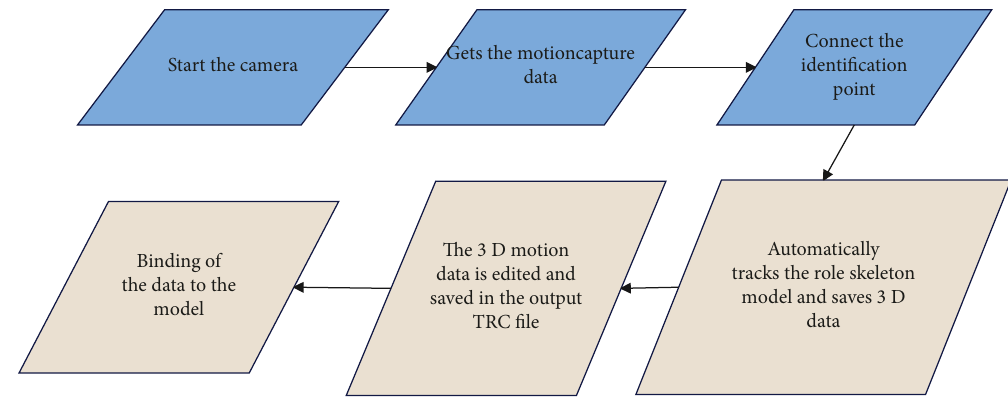
Figure 6: The dance movement skill feature recognition Table 1: The application effect of dance movement skill feature recognition system in dance teaching movement analysis.